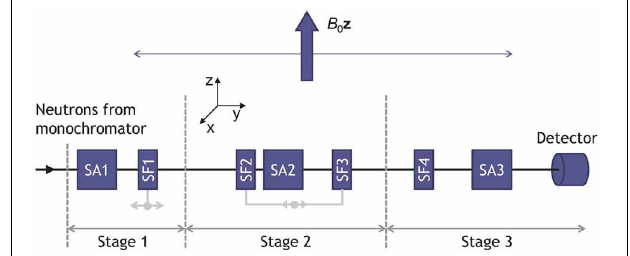
FIGURE 1 | Functional block diagram of the neutron experiment [14, 15] to test uncertainty relations, see also Figure 2 in Erhart et al. [14], Sulyok et al. [15]. Monochromatic neutrons enter from the left. SA1, SA2, SA3: spin analyzers (see text); SF1, SF2, SF3, SF4: spin flippers (see text). The positions of SF1 and the pair (SF2,SF3) are variable. The preparation stage 1 manipulates the magnetic moments of the neutrons such that, depending on the orientation of SA1 and the position of SF1, they leave stage 1 with their moments directed along the z -axis or along a fixed direction in the x − y plane. In the quantum theoretical description (see text), stages 2, 3 perform the successive measurement of the eigenvalues of the spin operators σ φ = σ x cos φ + σ y sin φ and σ y , respectively. These seven devices, in combination with the static magnetic field B 0 z and the variable positions of SF1 and (SF2,SF3), are sufficient to determine the expectation values that appear in Heisenberg-like uncertainty relations (see